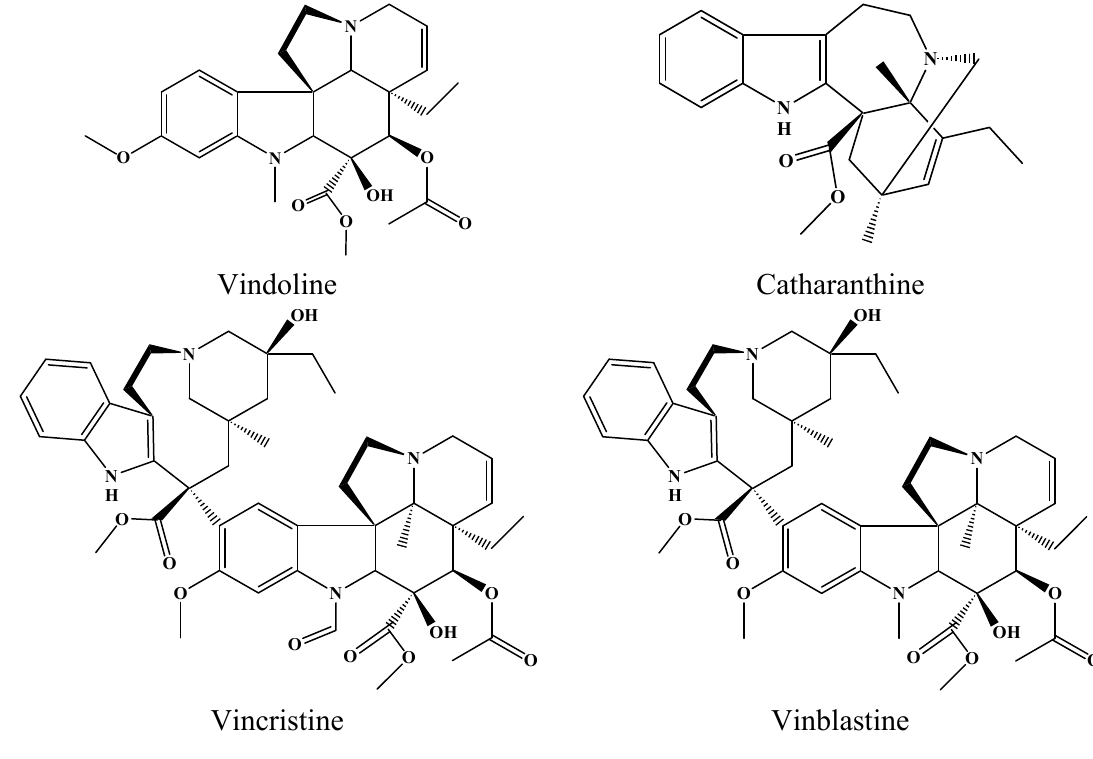
Figure 1. Chemical structure of vindoline (VDL) and catharanthine (CTR), vincristine (VCR), vinblastine